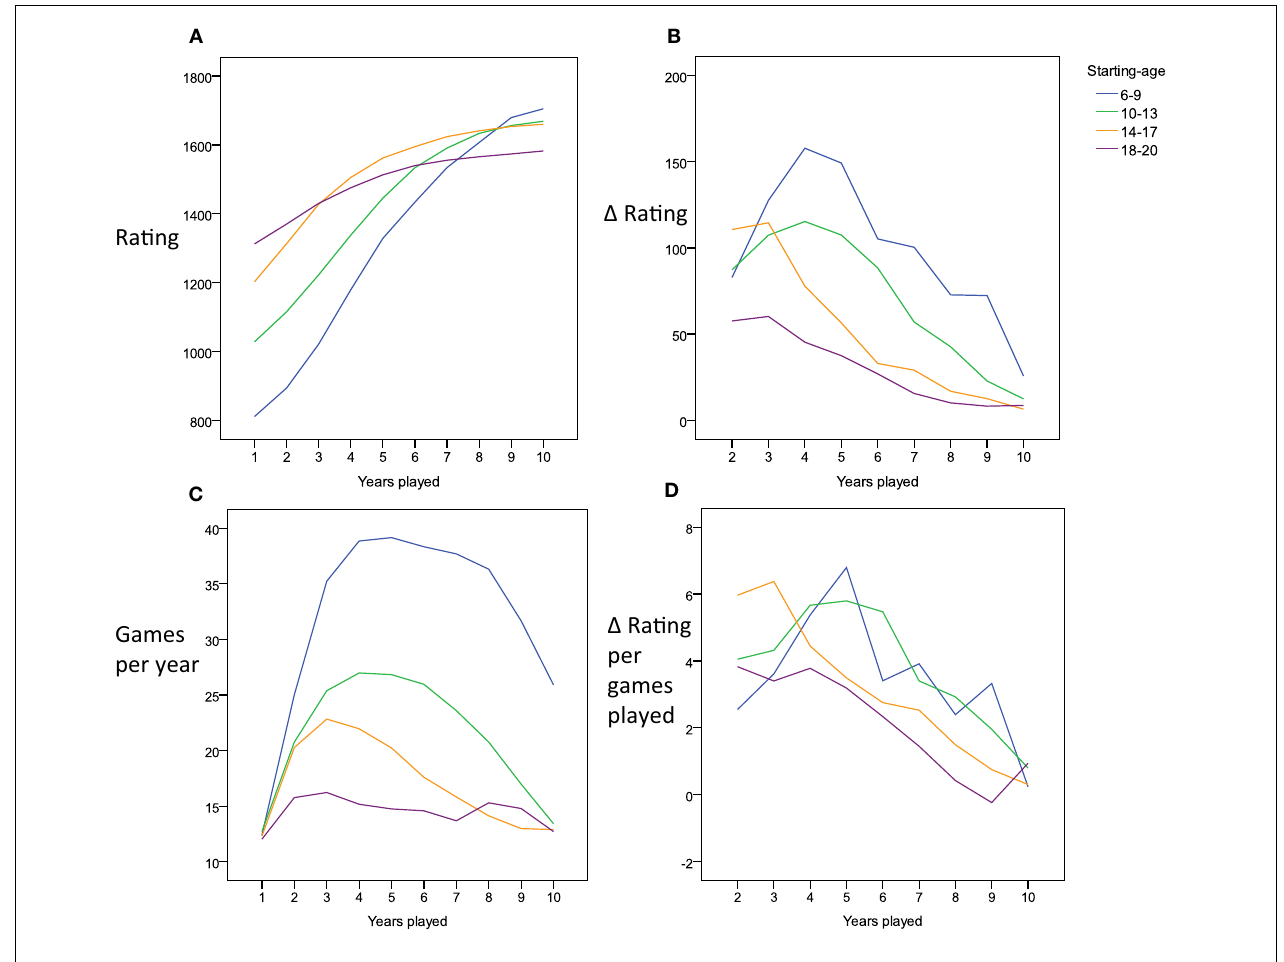
FIGURE 4 | (A) Charts the average time course in tournament performance for players starting at 6–20 years of age. (B) Shows the time course of the gain in performance from one year to the next for the different starting-age groups. In (C) the time course of number of